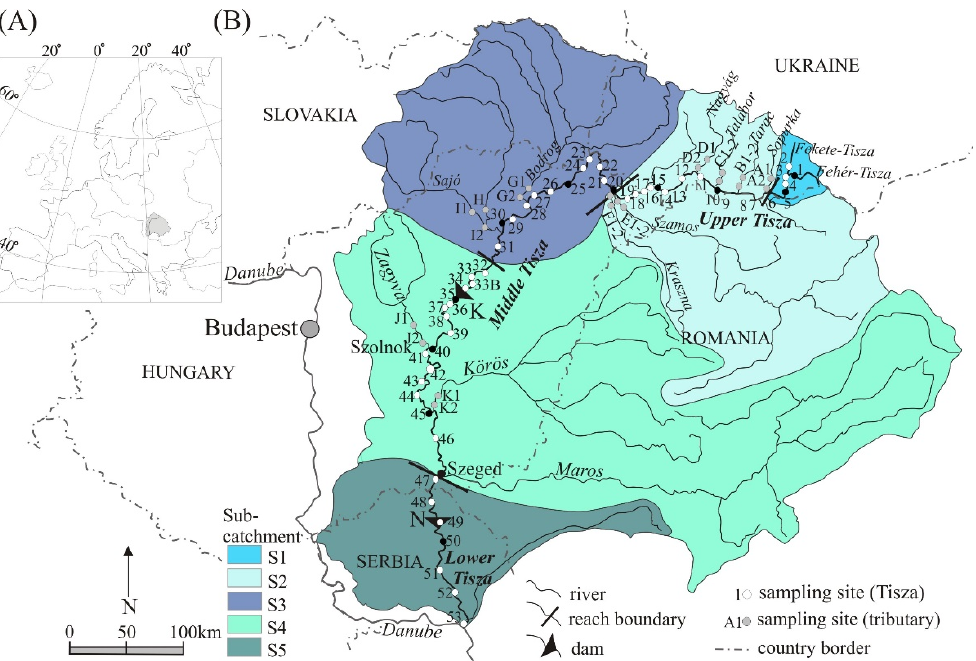
Figure 1. The microplastic pollution of the Tisza River in Central Europe was studied ( A ). The Tisza and its catchment was divided into three sections and sub-catchments ( B ). Numbers indicate the sampling points in the Tisza, and capital letters indicate the sampling sites in tributaries. The Kisköre Dam (K) and Novi Becej Dam (N), which influence the flow conditions, are also indicated.